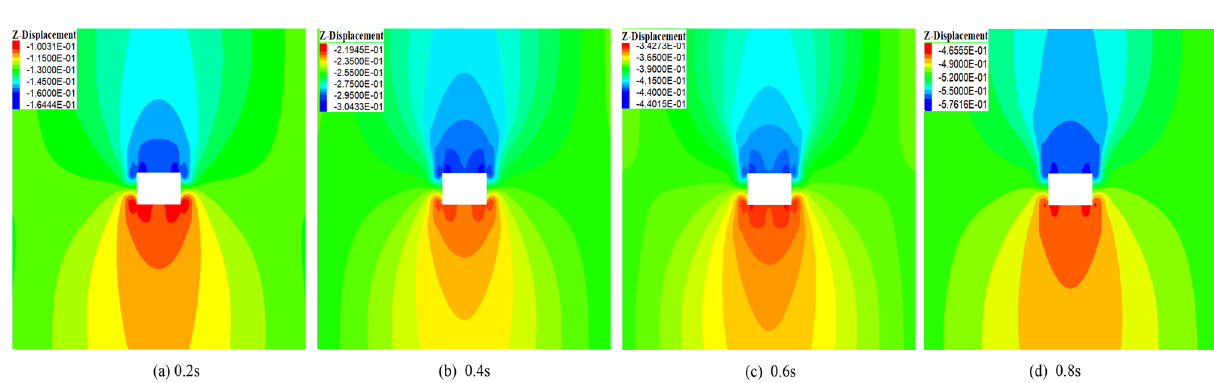
Figure 11. Deformation of surrounding rock under different disturbance